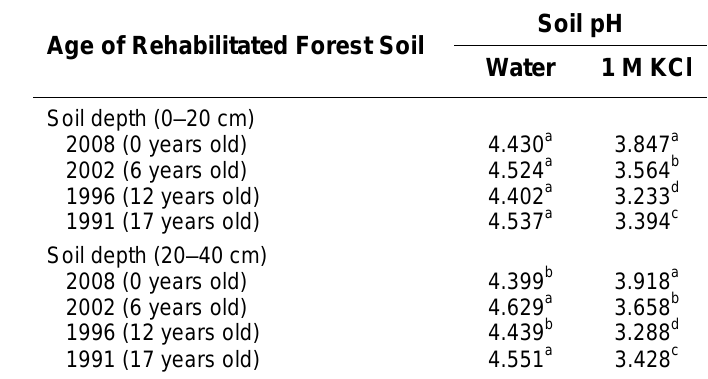
Age of Rehabilitated Forest